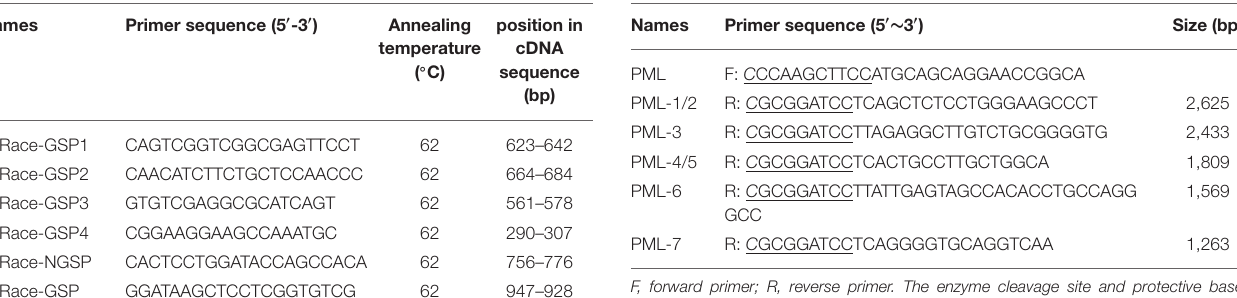
TABLE 1 | RACE primer sequences of PML gene. TABLE 2 | Primers used for porcine PML isoforms